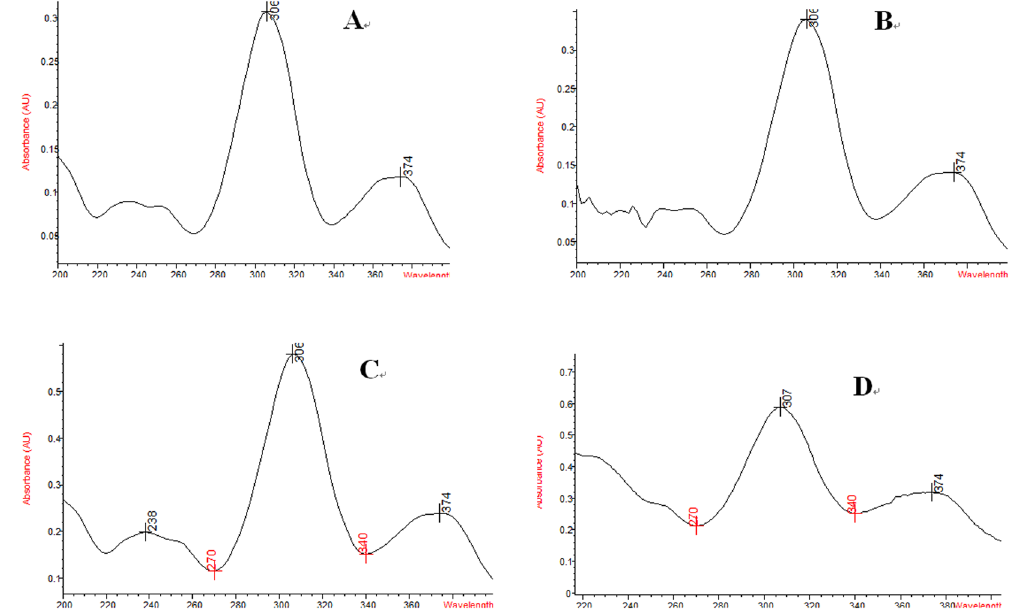
Figure 3. The UV scanning spectrum of Cyx preparations and standards. ( A ) Cyadox standards; ( B~D ) Cyadox preparations from three independent